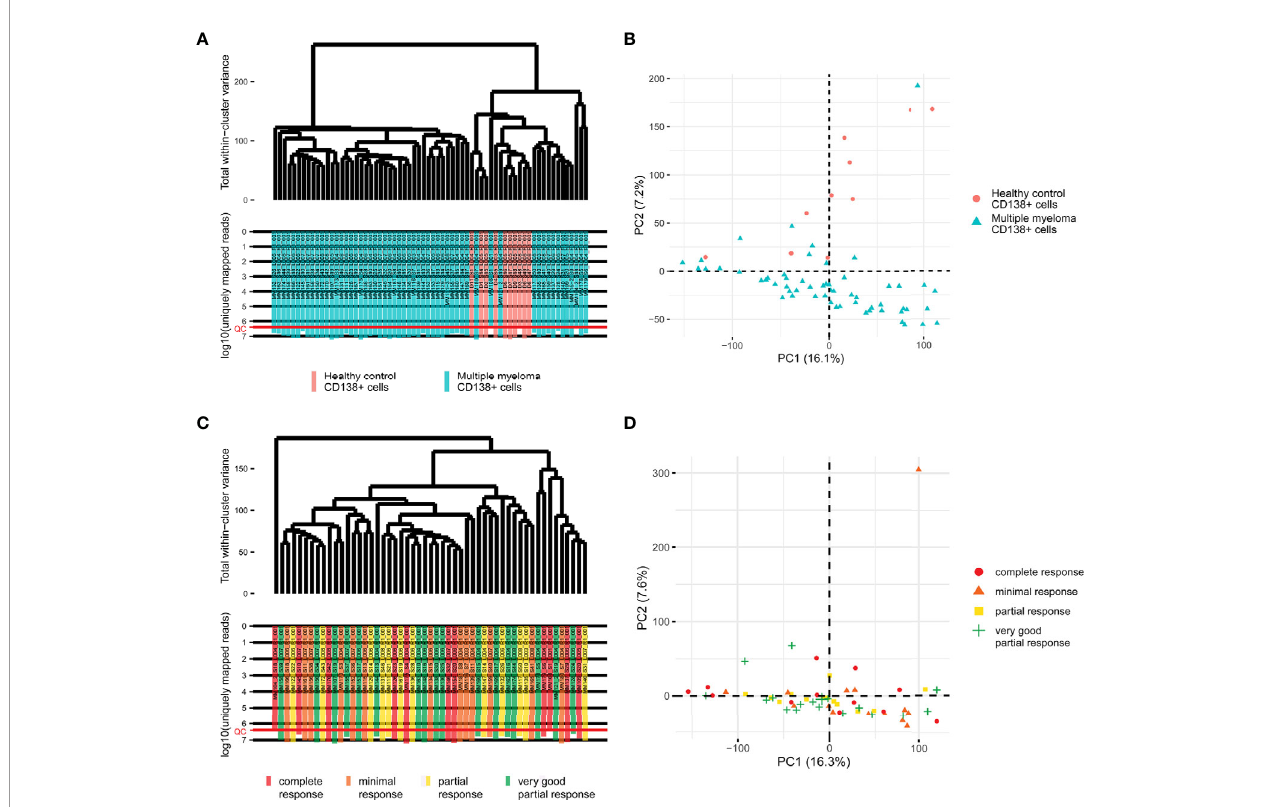
FIGURE 2 | (A) The hierarchical clustering dendrogram of QC-passed experimental RNA sequencing pro fi les of the control and multiple myeloma samples. Gene expression data were used to calculate Euclidian distances between the samples. The color markers indicate the sample types. The lower scale indicates the number of uniquely mapped reads. ‘ QC ’ denotes the quality control threshold of 2.5 million uniquely mapped reads. (B) PCA for QC-passed experimental RNA sequencing pro fi les of the control and multiple myeloma samples. The color markers indicate the sample types. (C) The hierarchical clustering dendrogram of QC- passed experimental RNA sequencing pro fi les of the multiple myeloma samples. Gene expression data were used to calculate Euclidian distances between the samples. The color markers indicate the response. The lower scale indicates the number of uniquely mapped reads. ‘ QC ’ denotes the quality control threshold of 2.5 million uniquely mapped reads. (D) PCA for QC-passed experimental RNA sequencing pro fi les of the multiple myeloma samples. The color markers indicate the